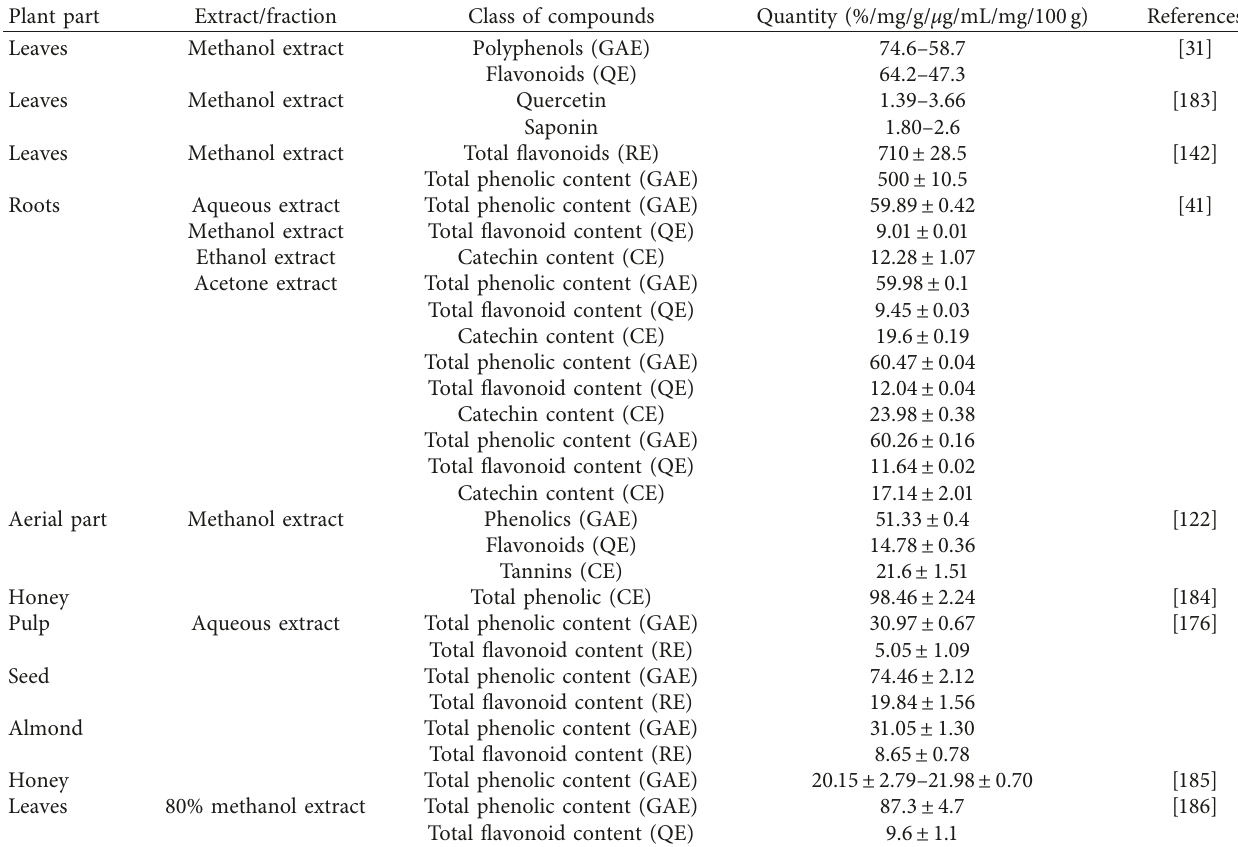
Table 3: Quantitative phytochemical data of Z. spina